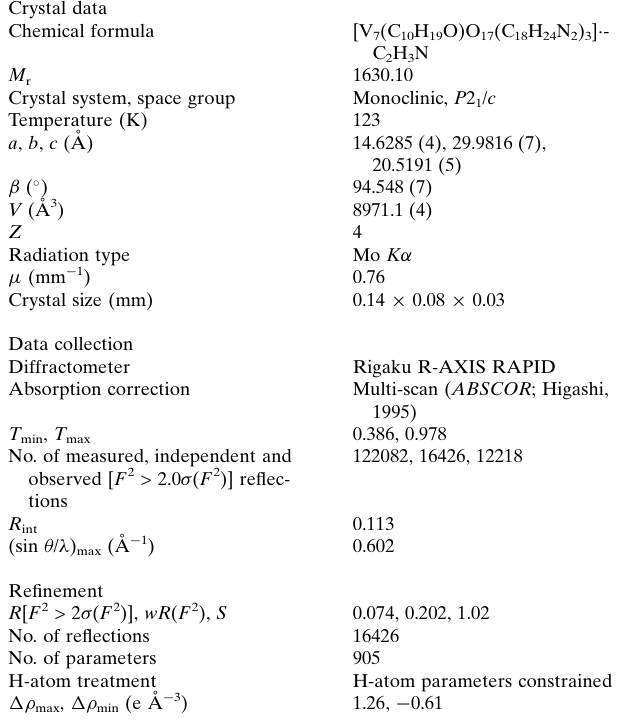
Table 2 Experimental details. Crystal data Chemical formula